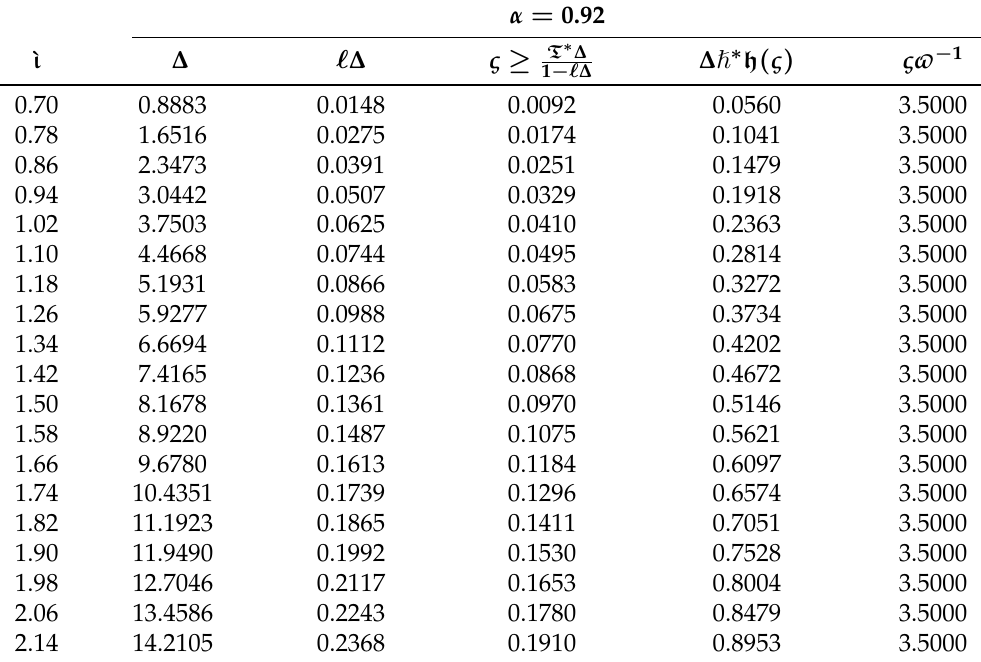
Table 6. Numerical values of ∆ , (cid:96) ∆ , ∆ (cid:125) ∗ h ( ς ) in Example 2 ∀ ` ι ∈ [ 0.7,2.1 ] when G = ` ι and α = 0.92. α =